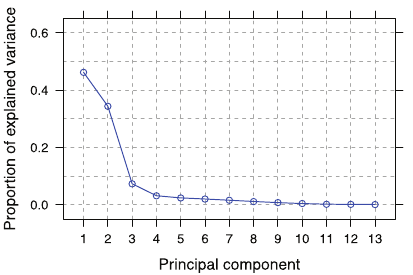
Figure 2. Importance of the principal components of the CPX frequency bands.